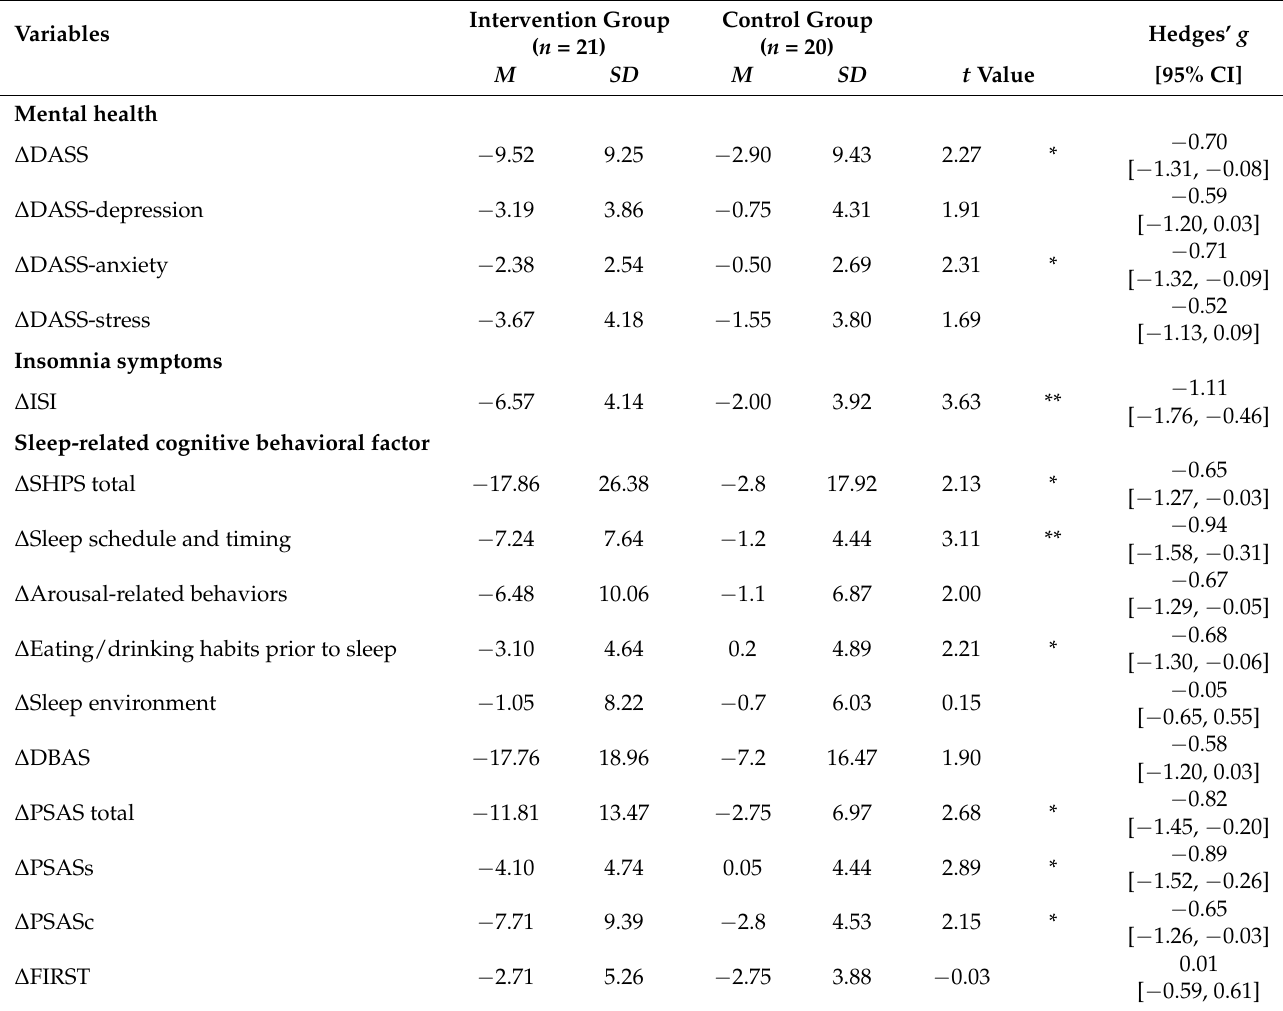
Table 1. Descriptive statistics of the changes in scores after